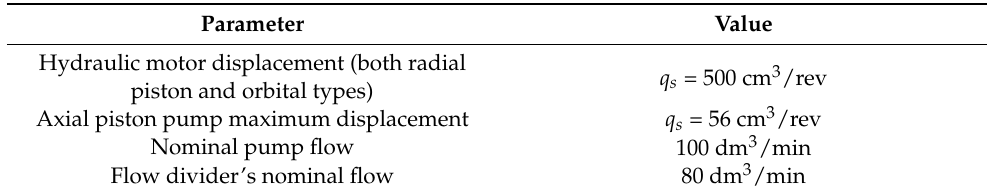
Table 3. Values of main hydrostatic drivetrain model parameters.